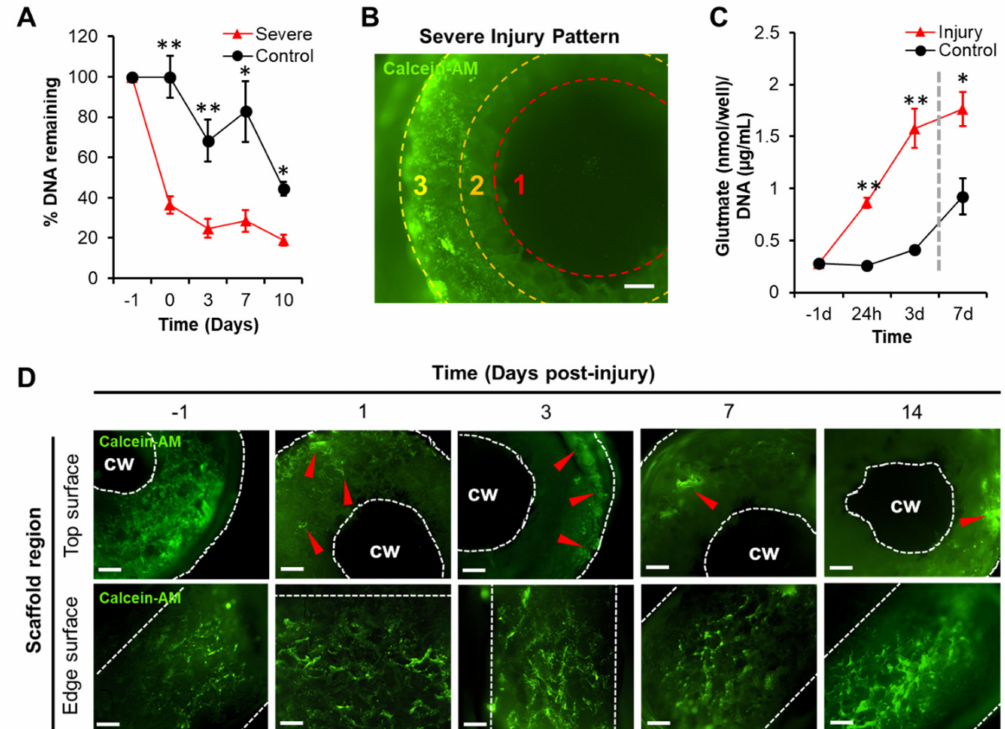
Figure 2. TBI model characterization to determine the injury severity, time-course, and biochemical changes. ( A ) DNA concentration within samples decreased significantly over time for the injured samples relative to the non-injured controls ( n = 102 samples total); Day 0 (** p < 0.001), Day 3 (** p < 0.001), Day 7 (* p < 0.005), and Day 10 (* p < 0.005). ( B ) Live imaging revealed a center-surround pattern of cell death wherein the initial injury physically removed cells from the central-most portion of the sca ff old (red, inner ring, 1), a ff ecting the neighboring regions that became cell-sparse (orange, middle ring, 2), though sparing the lateral-most regions (yellow, outer ring, 3). ( C ) Glutamate concentration within the media associated with samples that were injured increased markedly within 24 h of the initial injury (** p < 0.001) and remained elevated for 3 days post-injury (** p < 0.001); after changing the media (gray dotted line) and incubating for 3 more days, the glutamate concentrations remained elevated in media associated with injured samples relative to the controls (* p < 0.005). ( D ) Time-course imaging revealed that live cell populations along the top surface of the sca ff olds gradually receded away from the central window (cw) when the samples were injured and untreated, ultimately becoming reduced to patches of cells along the lateral portions of the tissue constructs (red arrows); however, the edge surface remained largely una ff ected. Means ± SEMs are provided. All image scale bars represent 500 µ